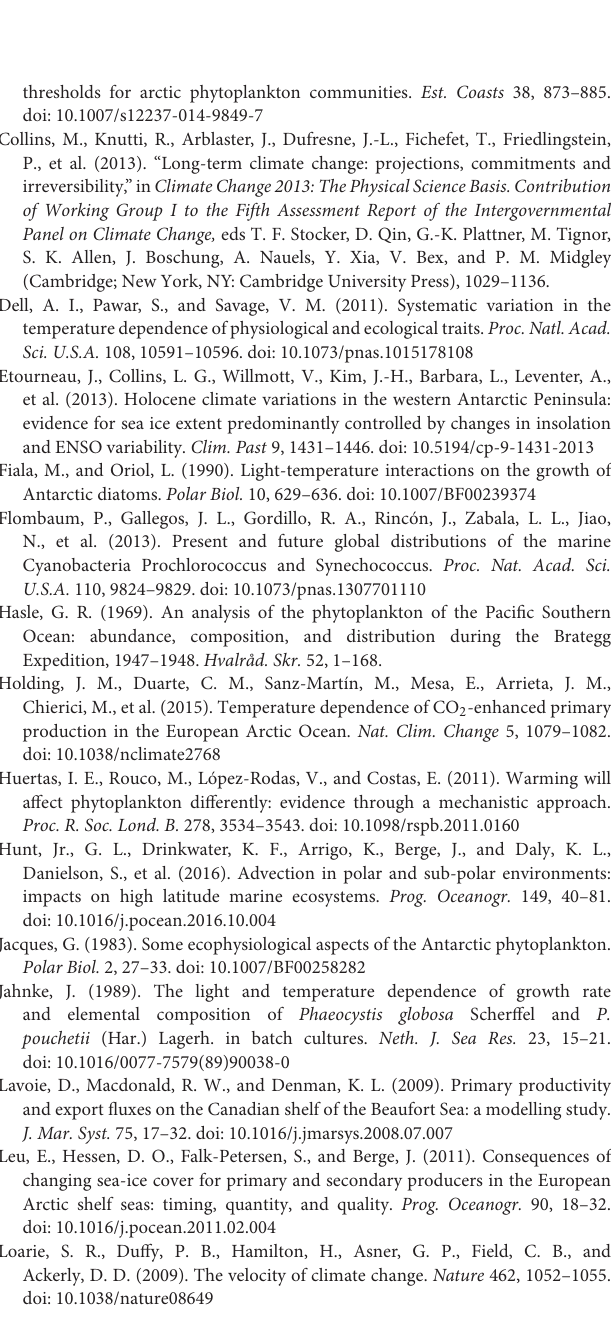
Figure 6 , N. Carrillo for sampling assistance and C. M.